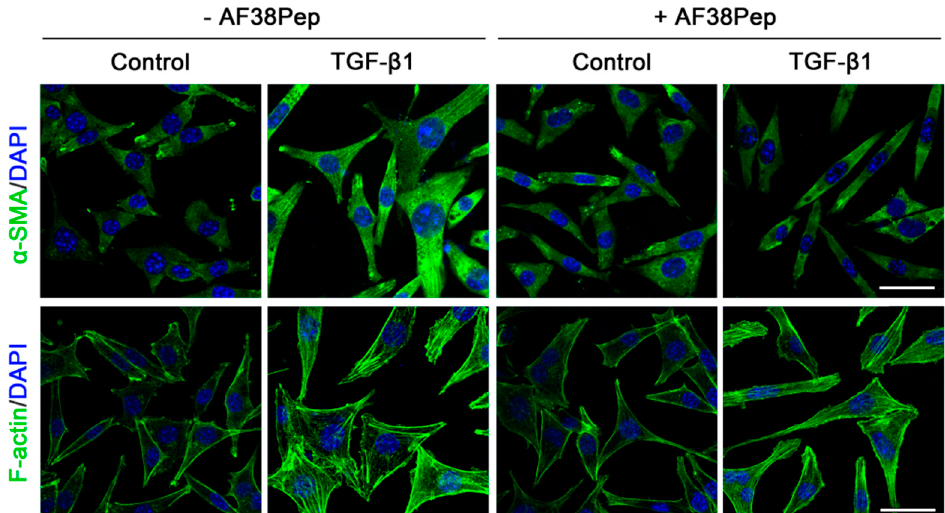
Figure 9. Assessment of blocking peptide effect on myofibroblast phenotype acquisition. NIH/3T3 fibroblasts were incubated in the presence or absence of 10 ng/mL TGF- β 1 with or without 10 µ g/mL of peptide for 48 h; immunocytochemistry was used to visualize the marker of myofibroblast differentiation ( α -SMA, green; DAPI, blue; top row; original magnification, x200; scale bar, 25 µ m) and an indicator of fibroblast activation to a proliferative, migratory and synthetic phenotype (F-actin, green; DAPI, blue; bottom row; original magnification, x200; scale bar, 25 µ m). Images are representative of three independent experiments.